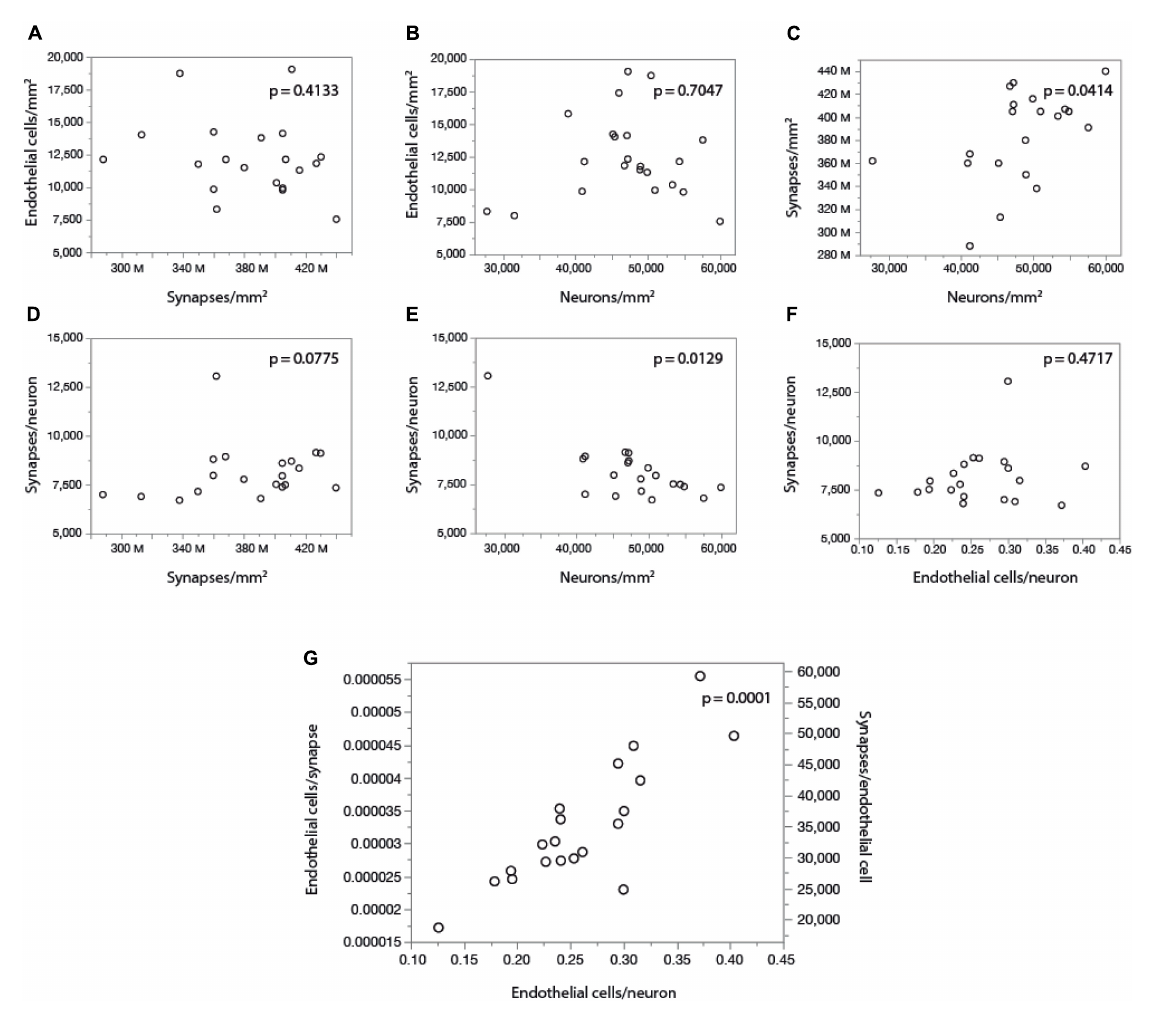
FIGURE9 With fairly constant numbers of synapses per neuron, the number of synapses served per endothelial cell increases together with the ratio of endothelial cells per neuron across sites in the mouse cerebral cortex. Data on local synaptic densities from Zhu et al. (2018) were combined to estimates of local densities of endothelial cells, neurons and glial cells in 2D images acquired in matching locations of the cerebral cortex as described in Zhu et al. (2018). Local densities of endothelial cells are not significantly correlated with local synaptic densities (A) or neuronal densities (B) . Sites with more neurons have marginally, but significantly, more synapses (C) , which is consistent with a lack of correlation between local synaptic density and the number of synapses per neuron (D) , although a correlation between average number of synapses per neuron and local neuronal density, due to one outlier, cannot be discarded (E) . Still, there is very clearly no correlation between local numbers of synapses per neuron and the ratio of endothelial cells per neuron (F) ; rather, the latter is directly, and strongly ( r 2 = 0.750), correlated with the ratio of endothelial cells per synapse (or its inverse, the number of synapses per endothelial cell; G) . All correlation coefficients are available in Table 6